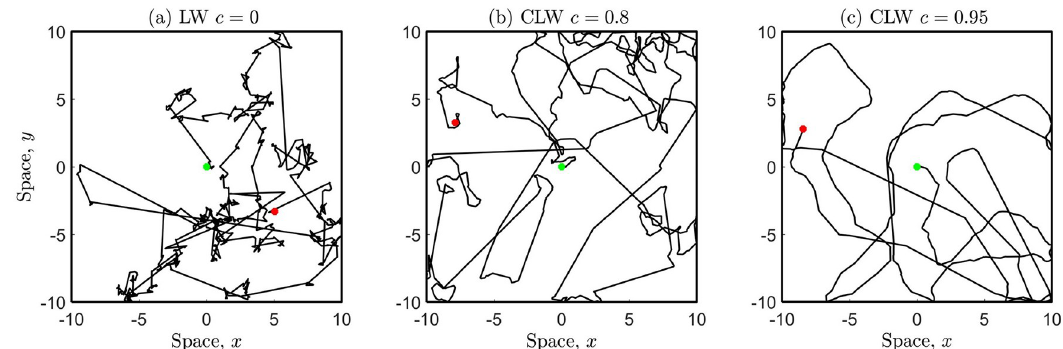
Fig 2. Individual movement paths for the CLW with mobility parameter γ = 0.1536. (a) LW c = 0 (special case) and (b) CLW c = 0.8, (c) CLW c = 0.95. Each individual has starting location at (0, 0) (green marker) and executes n = 1000 steps, corresponding to time t = 25 using a time increment of Δ t = 0.025. Note that these RWs are ‘comparable’ to those in Fig 1 since the movement scale parameters are related through the equivalence relation in Eq